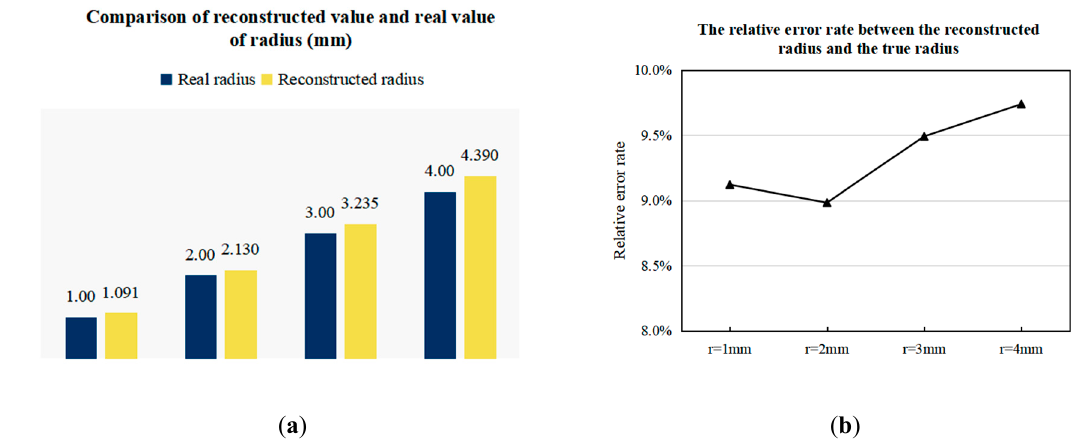
Figure 15. The electrode potential signal during a scanning cycle with different r .